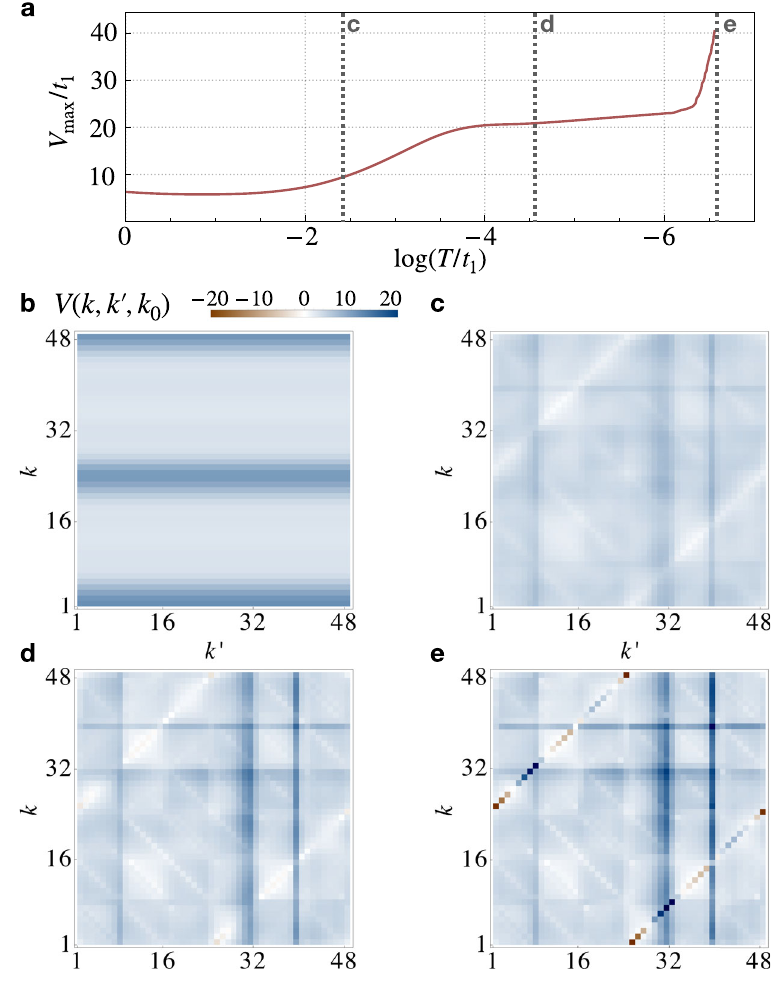
Fig. 6 Flow of the effective interaction. a Representative scale-dependence of the maximal value of the effective interaction V max ¼ max V ð k 1 ; k 2 ; k 3 ; k 4 Þ in the parameter region of the g + i g SC instability. During the different stages of the RG fl ow, the different interaction channels (i.e. the pp-channel and the ph-channels) contribute. The initial increase of V max for log T = t \ (cid:2) 4 is driven by the particle-hole (cid:2) 4 \ log T = t \ (cid:2) 6 ). fl uctuations. Suf fi ciently far away from nesting, these fl uctuations are not critical, i.e. V max nearly saturates (cf. plateau for Eventually, particle-particle fl uctuations lead to a divergence of the fl ow. b Interaction V with conventions as described in Fig. 2b for T = T 0 . c – e Interaction V for the three choices of T as indicated in panel ( a ), exhibiting different dominant features. The strongest vertical and horizontal features in c,d correspond to valley fl uctuations with momentum transfer of k 1 − k 3 = Q α and k 2 − k 3 = Q α ( α = 1, 2, 3), diagonal features in e are typical for superconductivity with k 1 + k 2 = k 3 + k 4 =